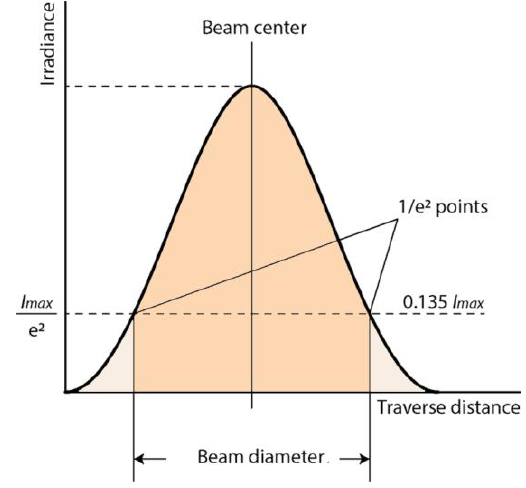
Figure 5. Gaussian laser beam with a circular cross section